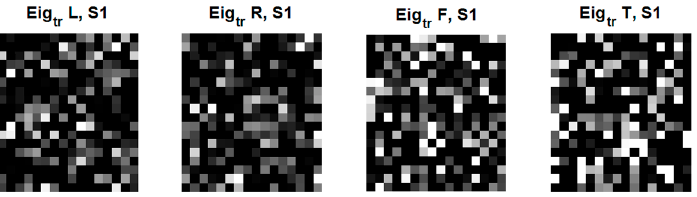
Figure 12. An original eigenface images of subjects for training data for 4 classes: left, right, feet, and tongue after whitening (18 × 16: = 72 × 4) in C4D2a_4C.